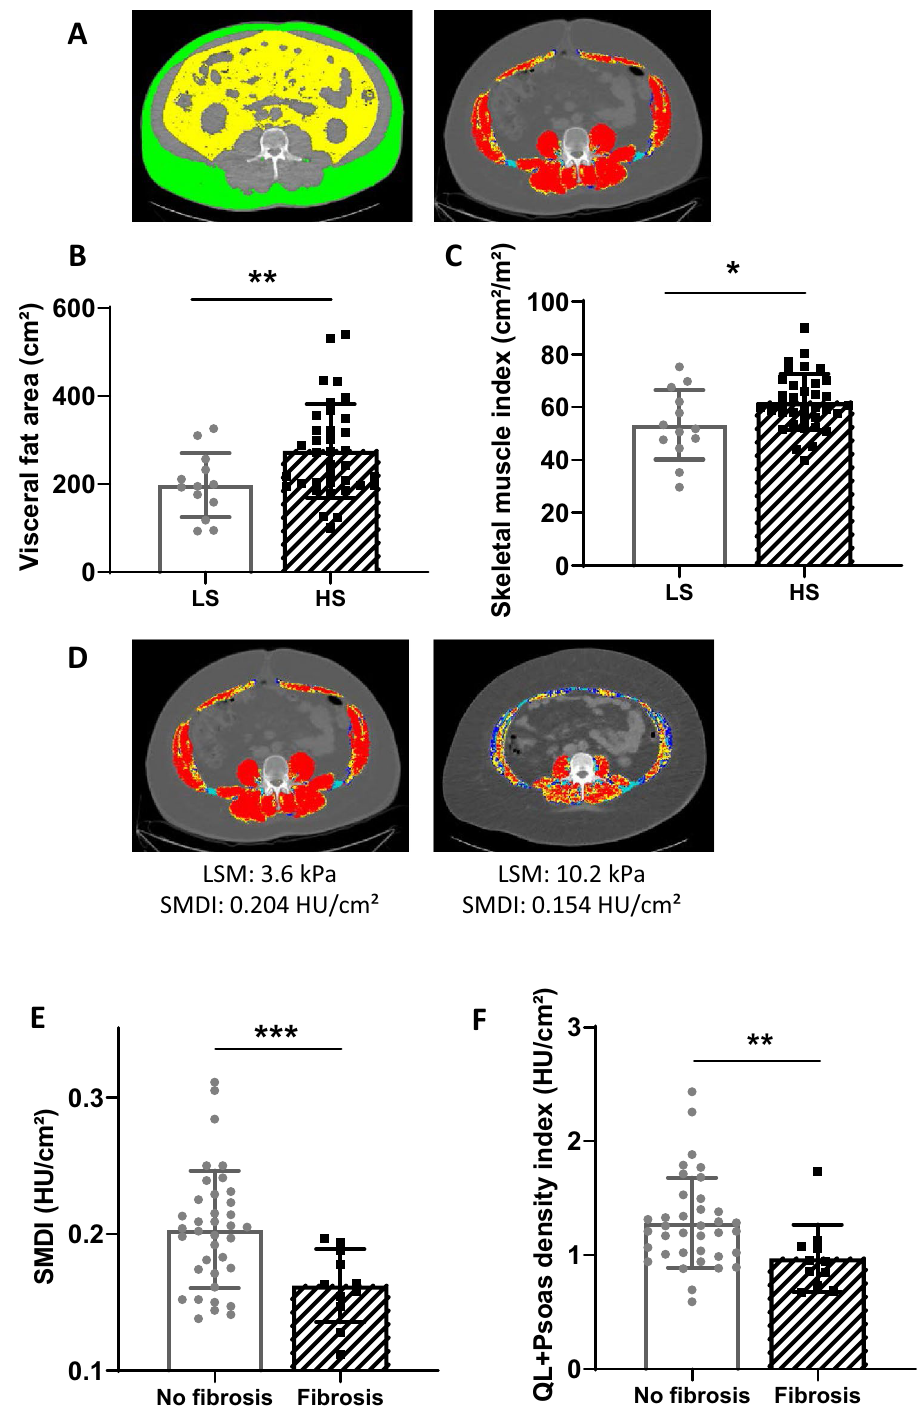
Figure 1. Body composition evaluation using computed tomography (CT) scan depending on the steatosis and fibrosis grades. Representative picture of the subcutaneous adipose tissue and the visceral fat are evidenced in yellow and green respectively at the third lumbar level, while the muscle area appears in red in patients ( A ). Mean visceral fat area ( B ) and skeletal muscle index ( C ) depending on the steatosis grade. n = 13 for patients with slight/moderate steatosis (LS), n = 36 for patients with severe steatosis (HS). Representative comparison of two MAFLD patients with obesity ( D ): patient at the left had normal liver stiffness measurement (LSM) with XL probe and normal mean muscle attenuation (skeletal muscles in red) and normal skeletal muscle density index (SMDI), whereas the patient at the right had a high LSM (with the XL probe also compatible with fibrosis), low mean muscle attenuation (skeletal muscles in red, yellow and blue) and low SMDI. Whole muscle density index ( E ) in the two groups (no fibrosis versus fibrosis) and quadratum lomborum (QL) + psoas density index ( F ) (n = 36 for patients with no fibrosis, n = 12 for patients with fibrosis. HU: Hounsfield unit. * p < 0.05, ** p < 0.01, *** p < 0.001. CT-scan images were processed with the Slice-O-Matic software, version 4.3 (Tomovision, Montreal, Canada). Heatmap representation was performed using Graphpad Prism software version 8 (www.graph